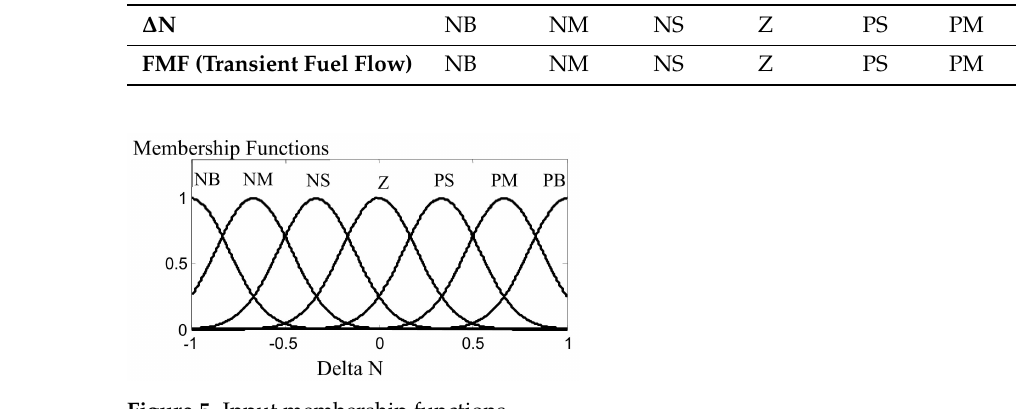
Figure 5. Input membership functions.